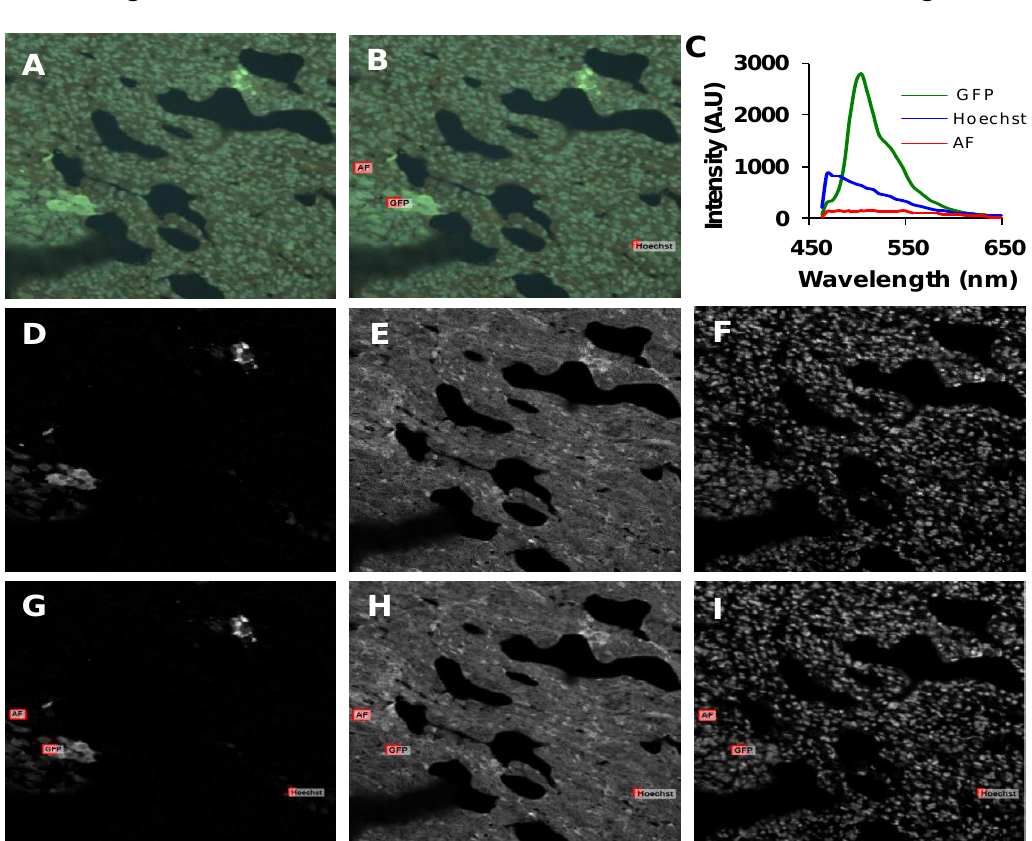
Figure 4. A representative image of a 10 μm lung cryoslice containing green fluorescent protein (GFP)-expressing cells and labeled with Hoechst. ( A ) False colored representation of spectral image data acquired on the confocal system. The signal-to-noise ratio (SNR) was calculated for the entire field of view (FOV); ( B ) Regions of interest (ROIs) corresponding to high emission of each fluorophore in the image were selected and the SNR was calculated for each ROI; ( C ) Mean fluorescence intensity corresponding to the ROI of each fluorophore averaged in five sequential images; ( D – F ) Linear unmixing of the image shown in panel A results in an abundance image for each endmember: GFP (D), autofluorescnece (E), and Hoechst (F). The SNR was calculated for each unmixed image using the entire FOV; ( G – I ) The same ROIs shown in panel B were applied to each unmixed image and the SNR was calculated for each ROI in each unmixed